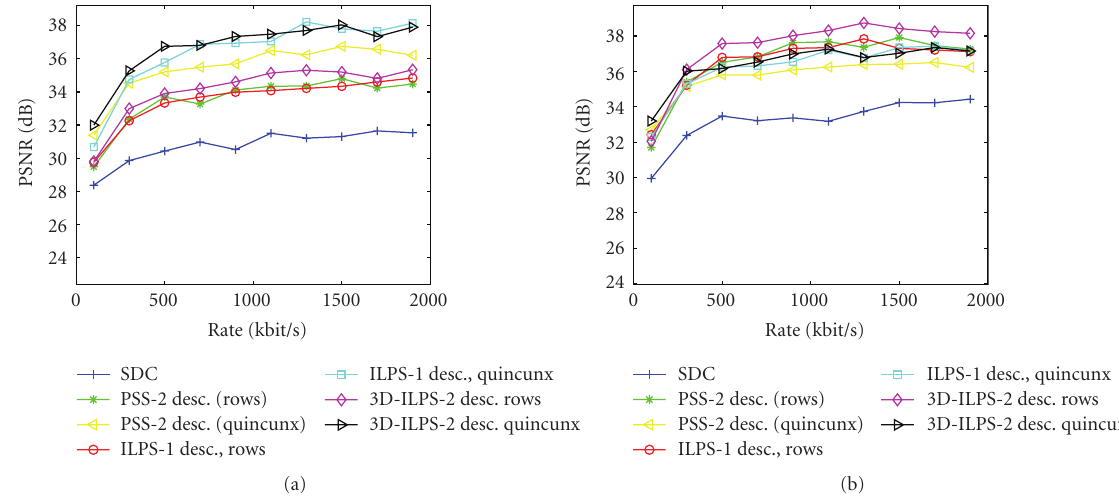
Figure 15: Performance of left view, two subsequences received, 10% packet loss. (a) Breakdance. (b) Ballet.